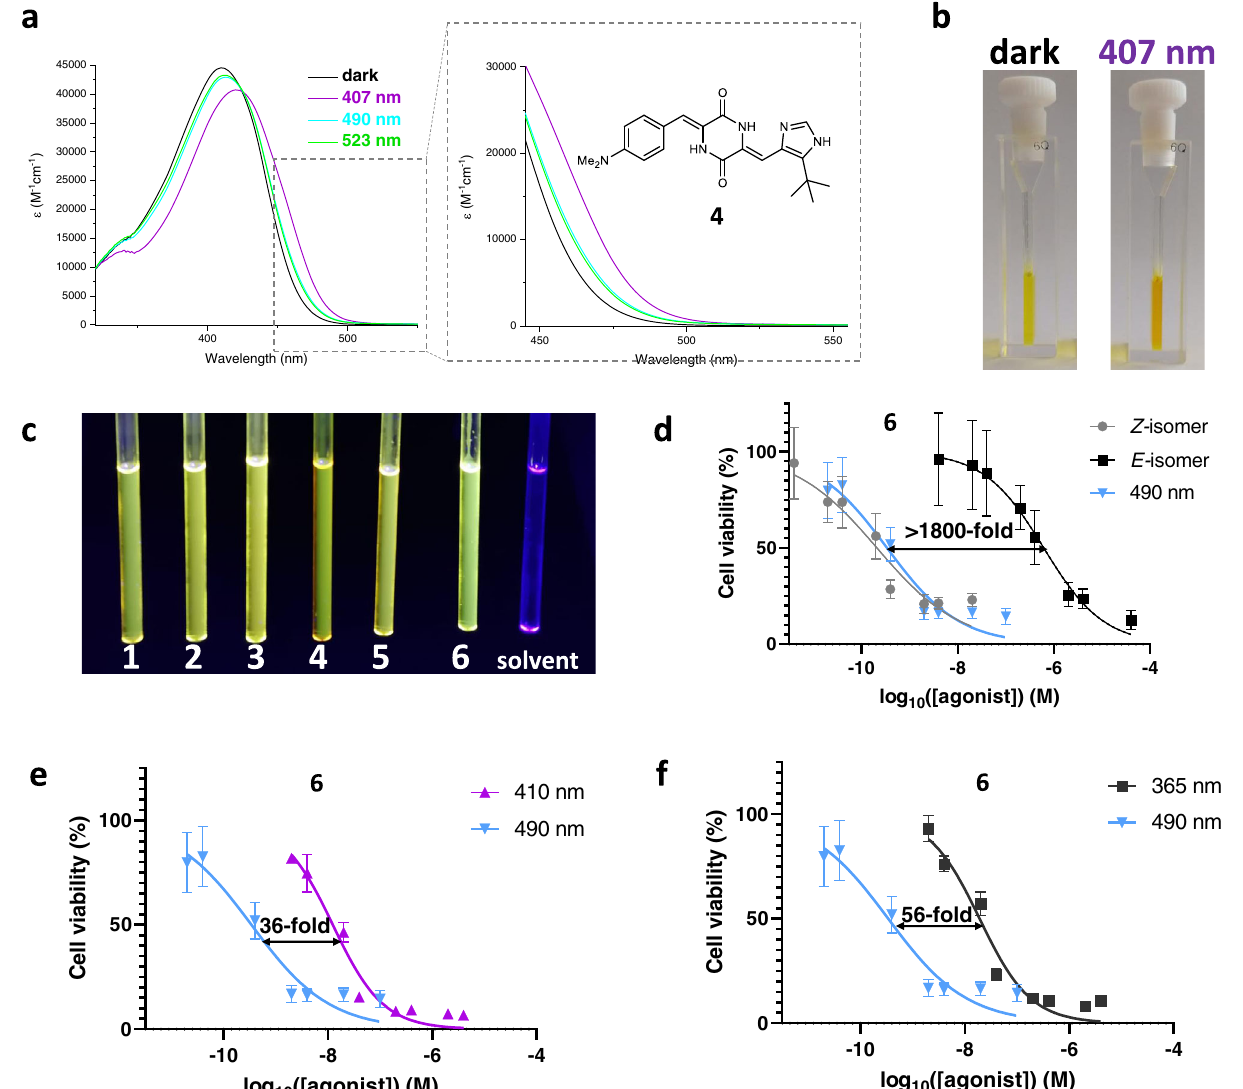
Fig. 3 | Plinabulin derivatives – photochromism, fl uorescence and cytotoxicity photomodulation.a UV-Visspectraofthe4-( N,N- dimethylamino)-plinabulin 4 asa puri fi ed Z- isomer(dark),andatrespectivephotostationarystates(407nm,490nm, and 523nm); b photochromism of 4 – the HPLC-puri fi ed dark sample containing >95% Z- 4 ,andthesampleequilibratedat407nm(55%ofthe E- 4 ); c fl uorescenceof compounds 1-6 upon excitation with UV light (365nm); 30-60mM solutions in DMSO, compared with a solvent sample; d demonstration of a potential prodrug applicationof E- 6 – theHPLC-isolatedthermallymetastable E- 6 (IC 50 =618nM)can beirreversiblyconvertedwithcyanlight(490nm)intoamixturecontaining86% Z- 6 with the IC 50 =0.34nM (>1800-fold activity enhancement). Data were plotted against the log of agonist concentration (log 10 ([agonist]) (M)) with mean and SD